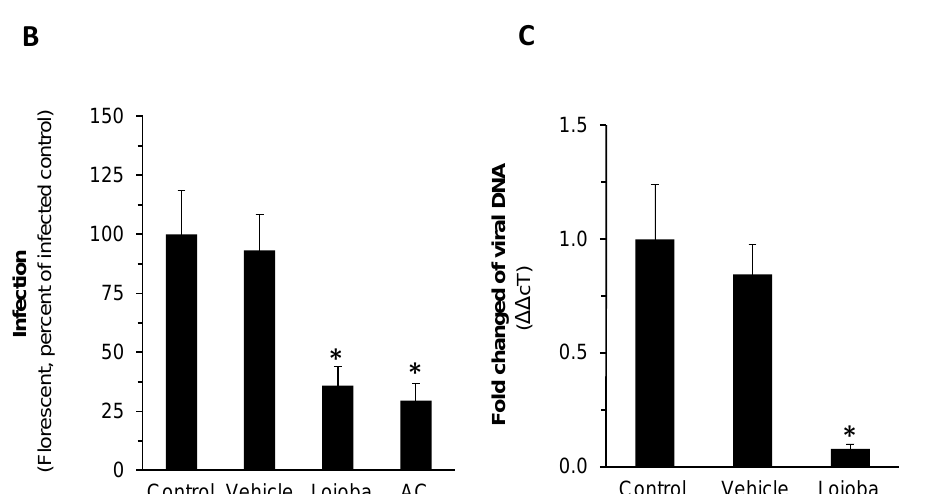
Figure 4. The impact of Jojoba wax on HSV-1 expression level. Infected Vero cells were treated with or